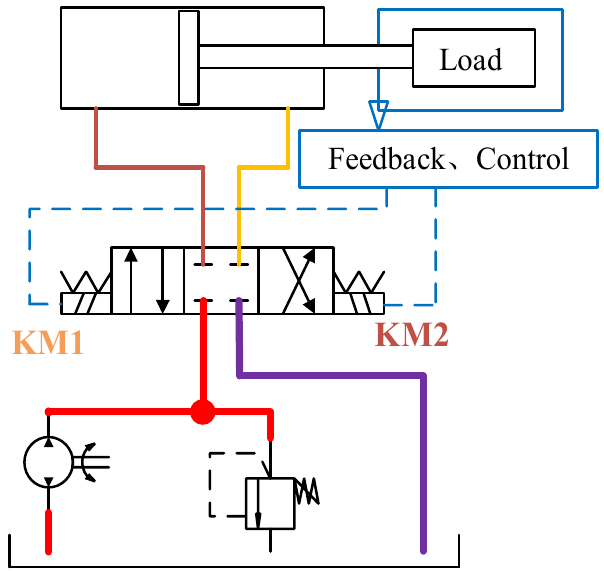
Figure 7. Schematic diagram of hydraulic cylinder displacement control.